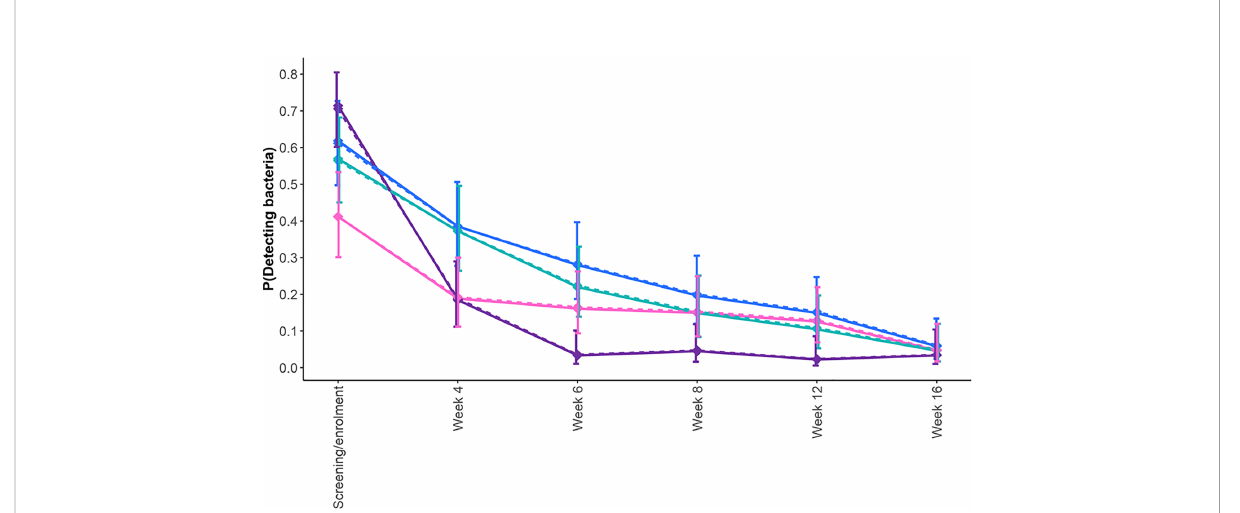
FIGURE 3 Estimated probability of detecting bacteria longitudinally in sputum specimens from participants with drug-resistant TB during treatment. Shown are the pro fi les of the probability of detecting DCTB within any of the MPN assays, CF-dependent DCTB (blue line); Rpf-independent DCTB (pink line); and CF-independent DCTB (teal line) and CFU (purple line) from screening/enrollment to 12 weeks after randomization. To determine the differences between the probabilities of detecting bacteria at each time point and across time points, we fi tted a longitudinal generalized estimating equation (the results are presented in Table S2). The solid lines represent the adjusted model, and the dotted lines represent the unadjusted